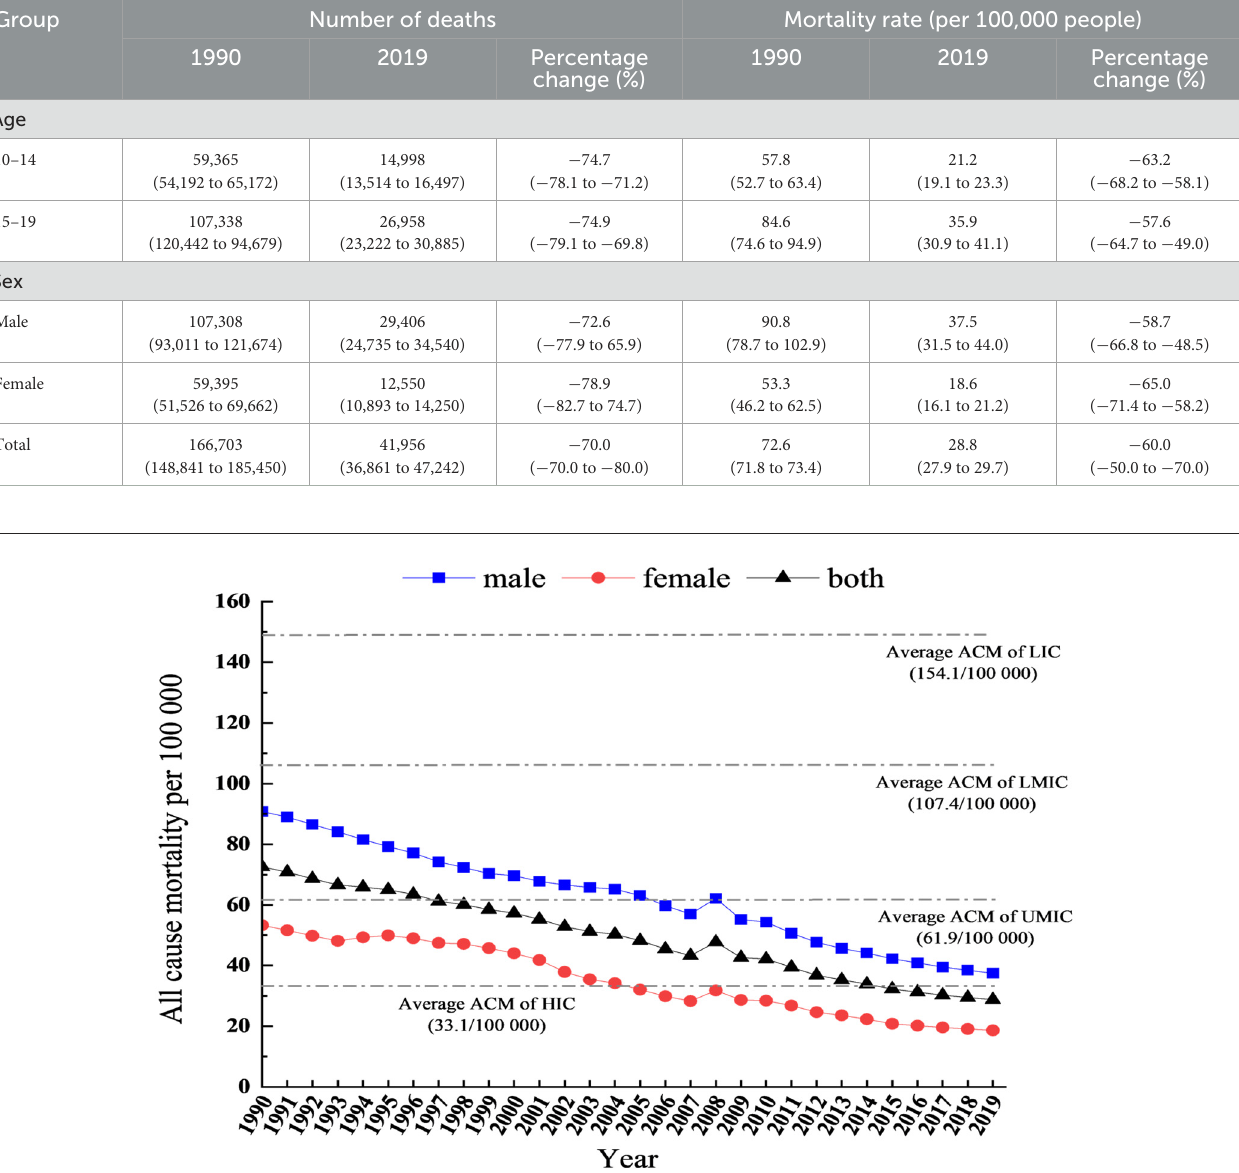
TABLE 1 The mortality rates, deaths, and changes for all causes of death among adolescents by sex and age from 1990 to 2019.